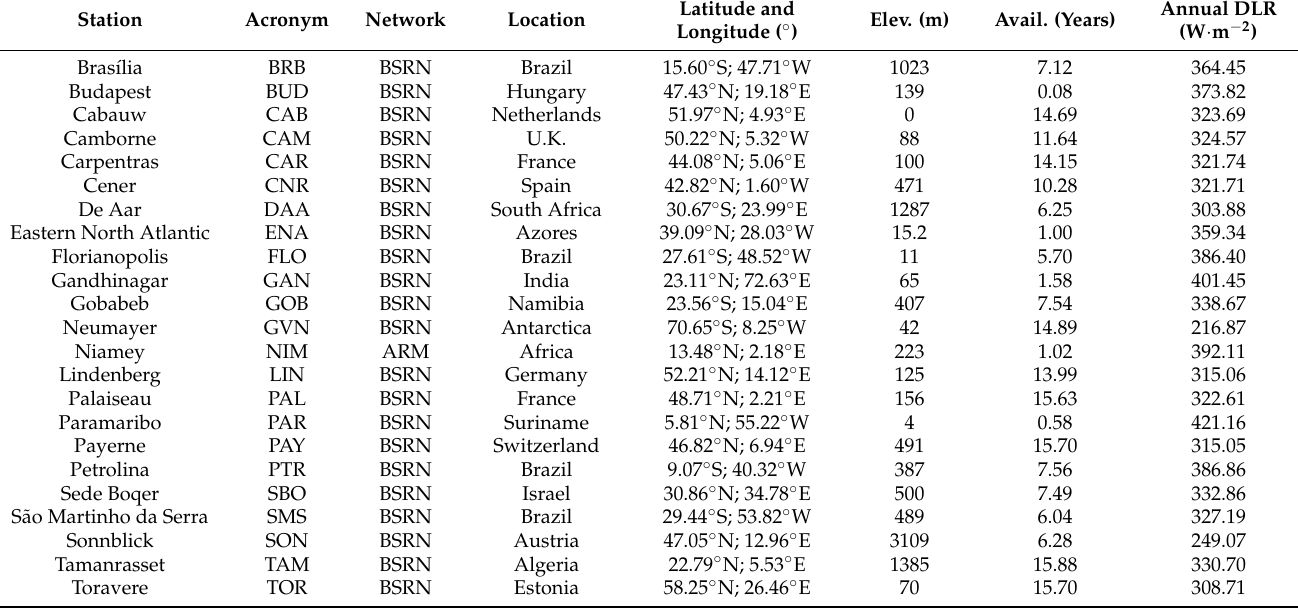
Table 1. List of 23 stations used within the Meteosat Second Generation (MSG) disk for validation purposes of estimated downward long-wave radiation (DLR) at the surface. The name, acronym, network of origin, location, geographical coordinates (°), elevation (m), availability (total number of years available between 2004 and 2019), and annual mean DLR (W.m − 2 ) for each station is shown.